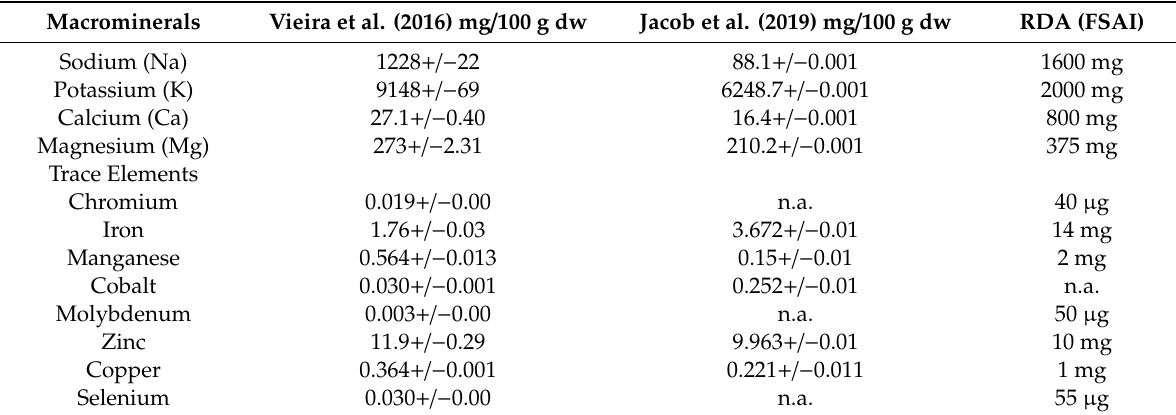
Table 2. Mineral Composition of Brewer’s Spent Yeast Extract